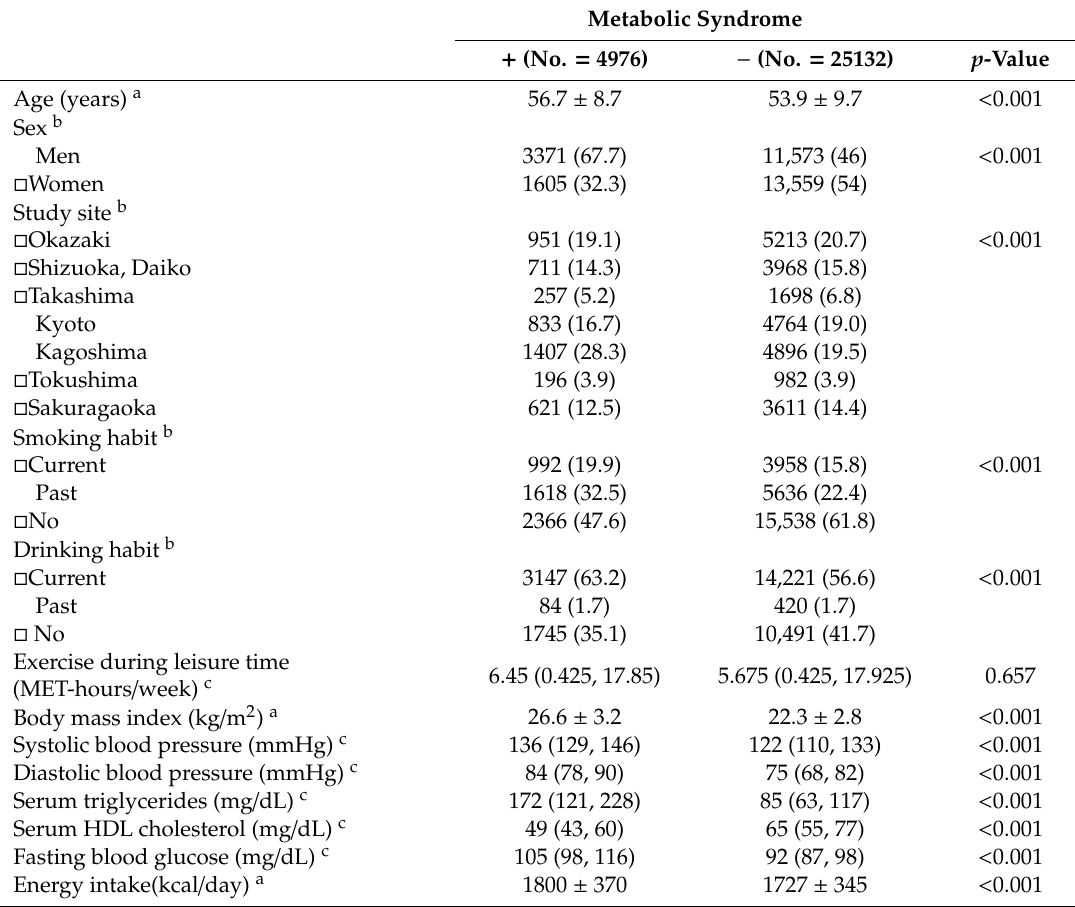
Table 1. Background characteristics of the study subjects according to the presence of metabolic